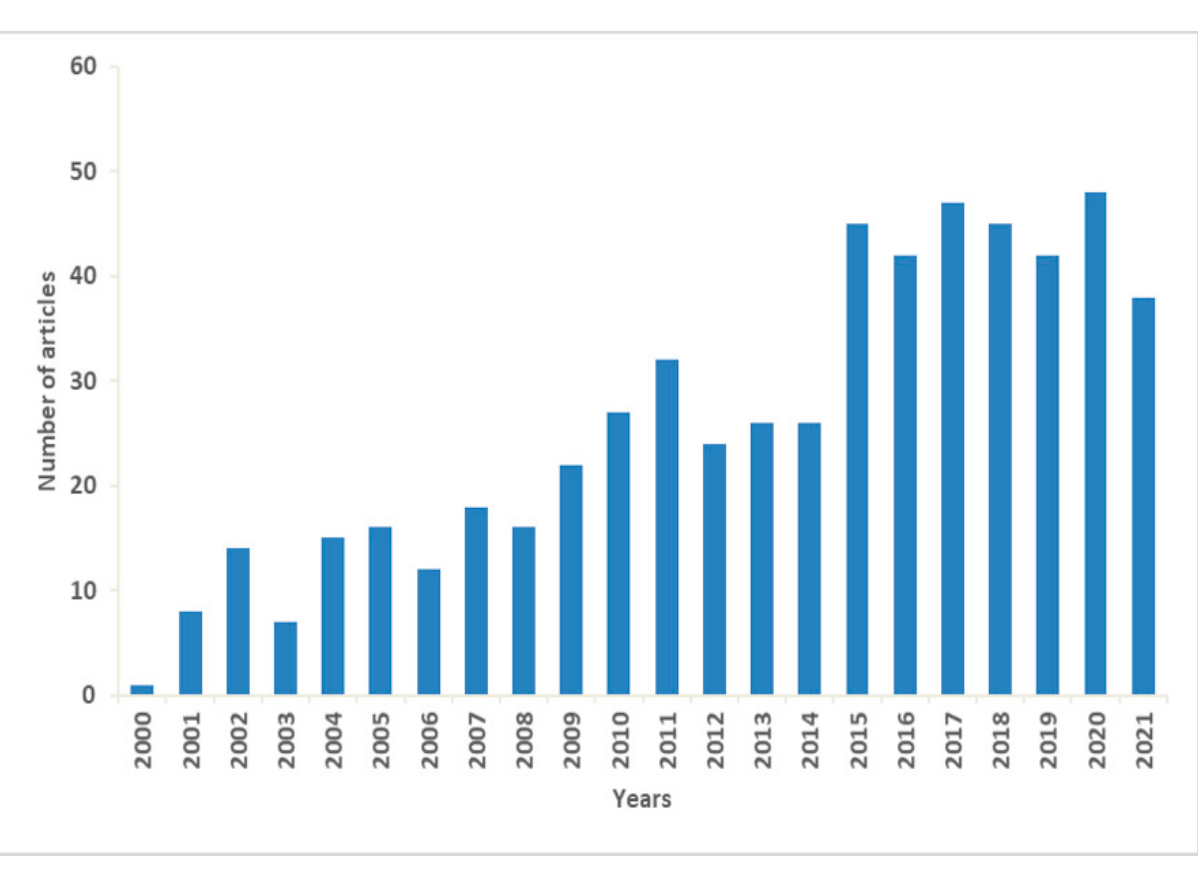
Figure 1. Number of articles on the effects of extreme rainfall events in the Mediterranean Basin published from 2000 to 2021 ( n = 571).